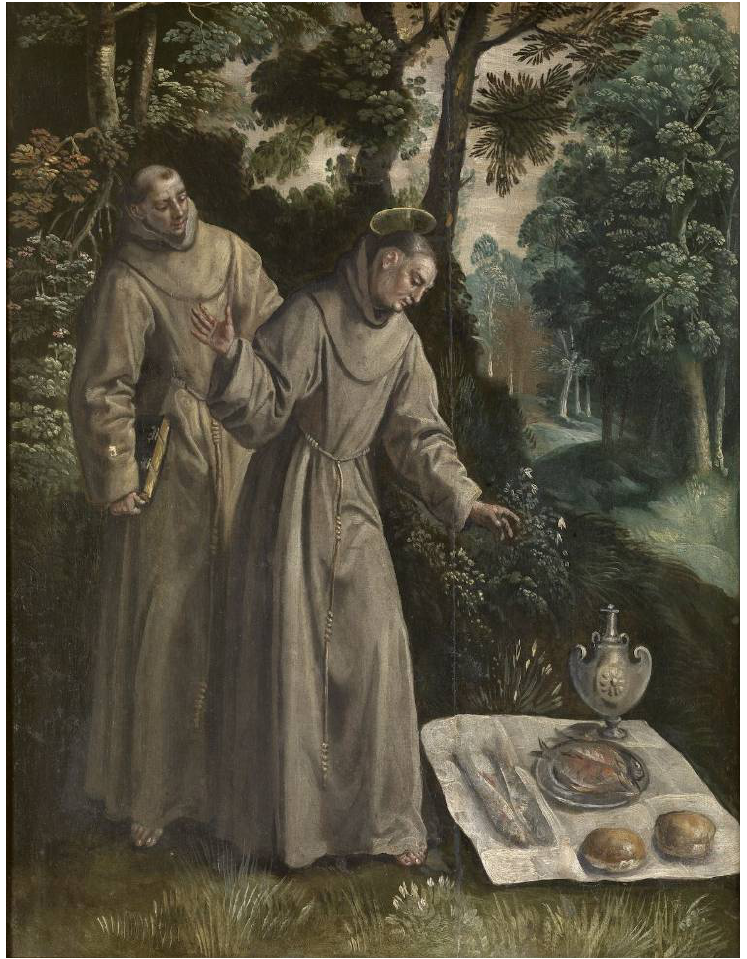
Figure 2. Maarten de Vos. In the Clearing of a Forest, Didacus Finds Bread, Fish and Wine, from the altarpiece The Story of Saint Didacus of Alcalá. 1591–1600. Oil on panel. Artwork in the public domain (Creative Commons); image courtesy of Royal Museum of Fine Arts in Antwerp/Koninklijk Museum voor Schone Kunsten Antwerpen—www.artinflanders.be (accessed on 1 October 2020)—Photo by Dominique Provost.